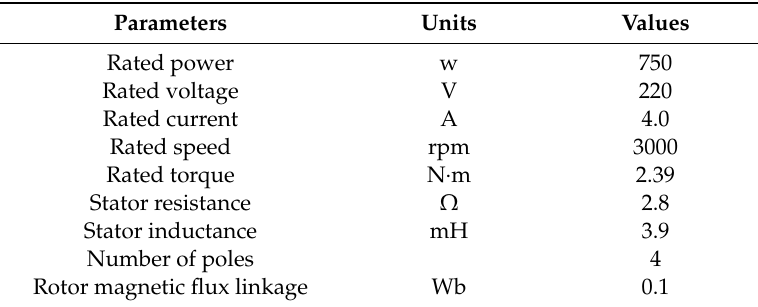
Table 5. Parameters of the tested